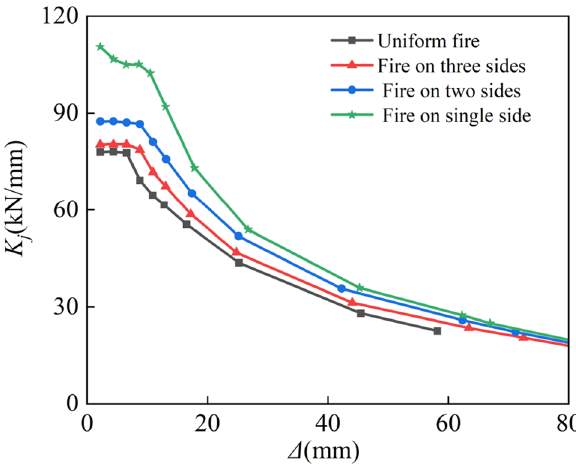
Figure 17. Stiffness degradation.